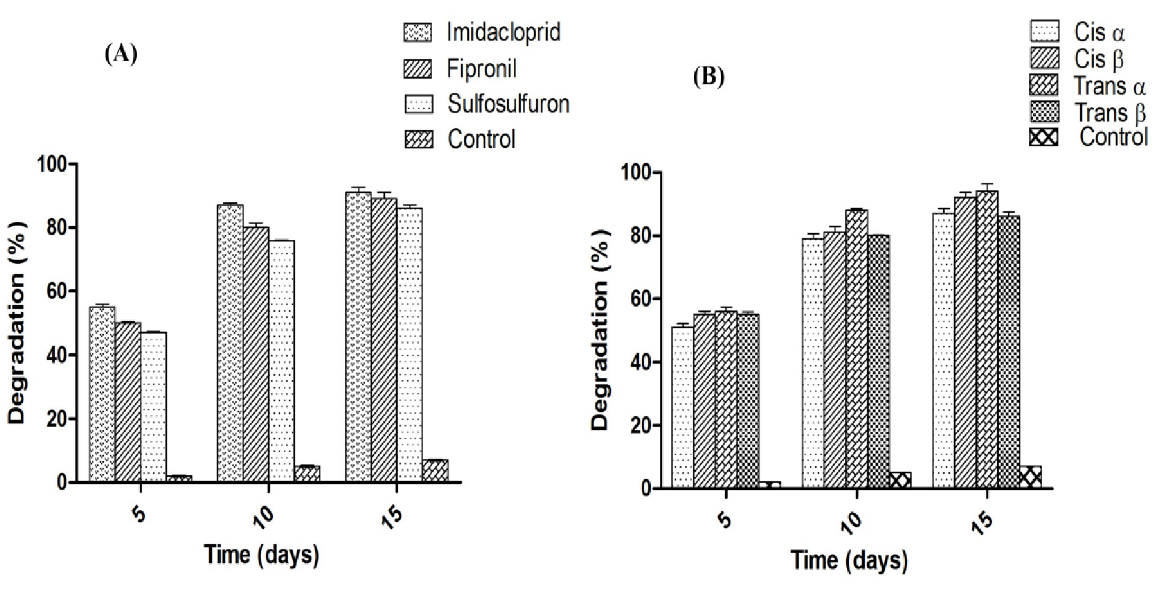
Fig 1. Biodegradation of imidacloprid, fipronil, sulfosulfuron and cypermethrin in minimal medium by 2D bacterial isolate. The graph denotes % degradation (Y axis) verses times in days (X-axis), where the numbers 5, 10 & 15 represent the withdrawal of sample(s) at different time interval. (A) Represents the biodegradation of imidacloprid, fipronil, sulfosulfuron while (B) represents the biodegradation of different isomers of cypermethrin.